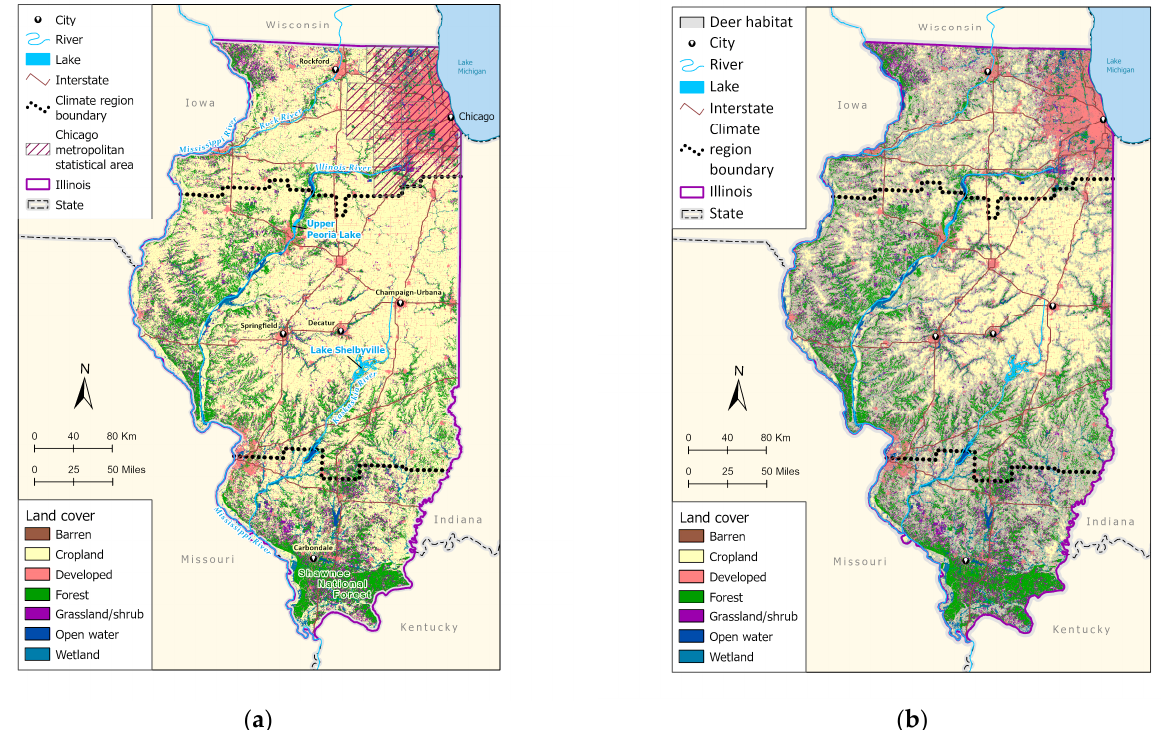
Figure 1. ( a ) National Land Cover Database [54] aggregated landcover classes for Illinois. Climate region boundaries are derived from the National Oceanic and Atmospheric Administration U.S.